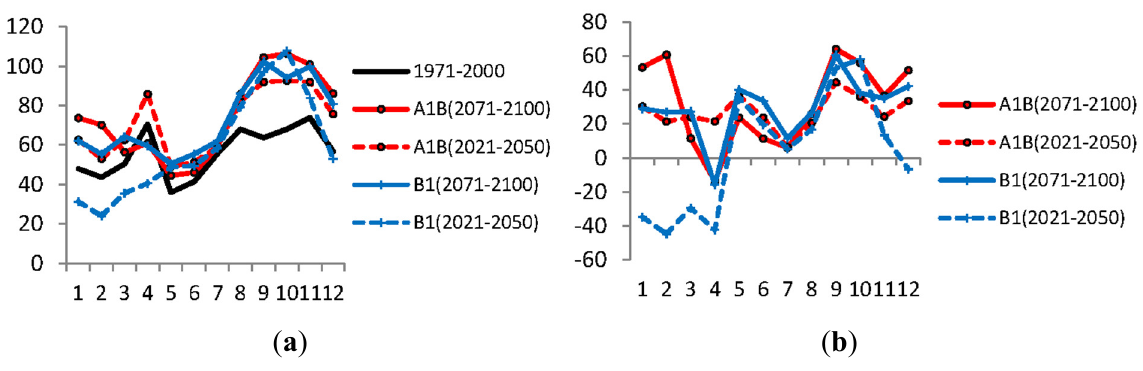
Figure 9. ( a ) Mean monthly potential infiltration rate (mm); ( b ) change in initial infiltration rate (%) in the A1B and B1 scenarios during the periods 2021–2050 and 2071–2100